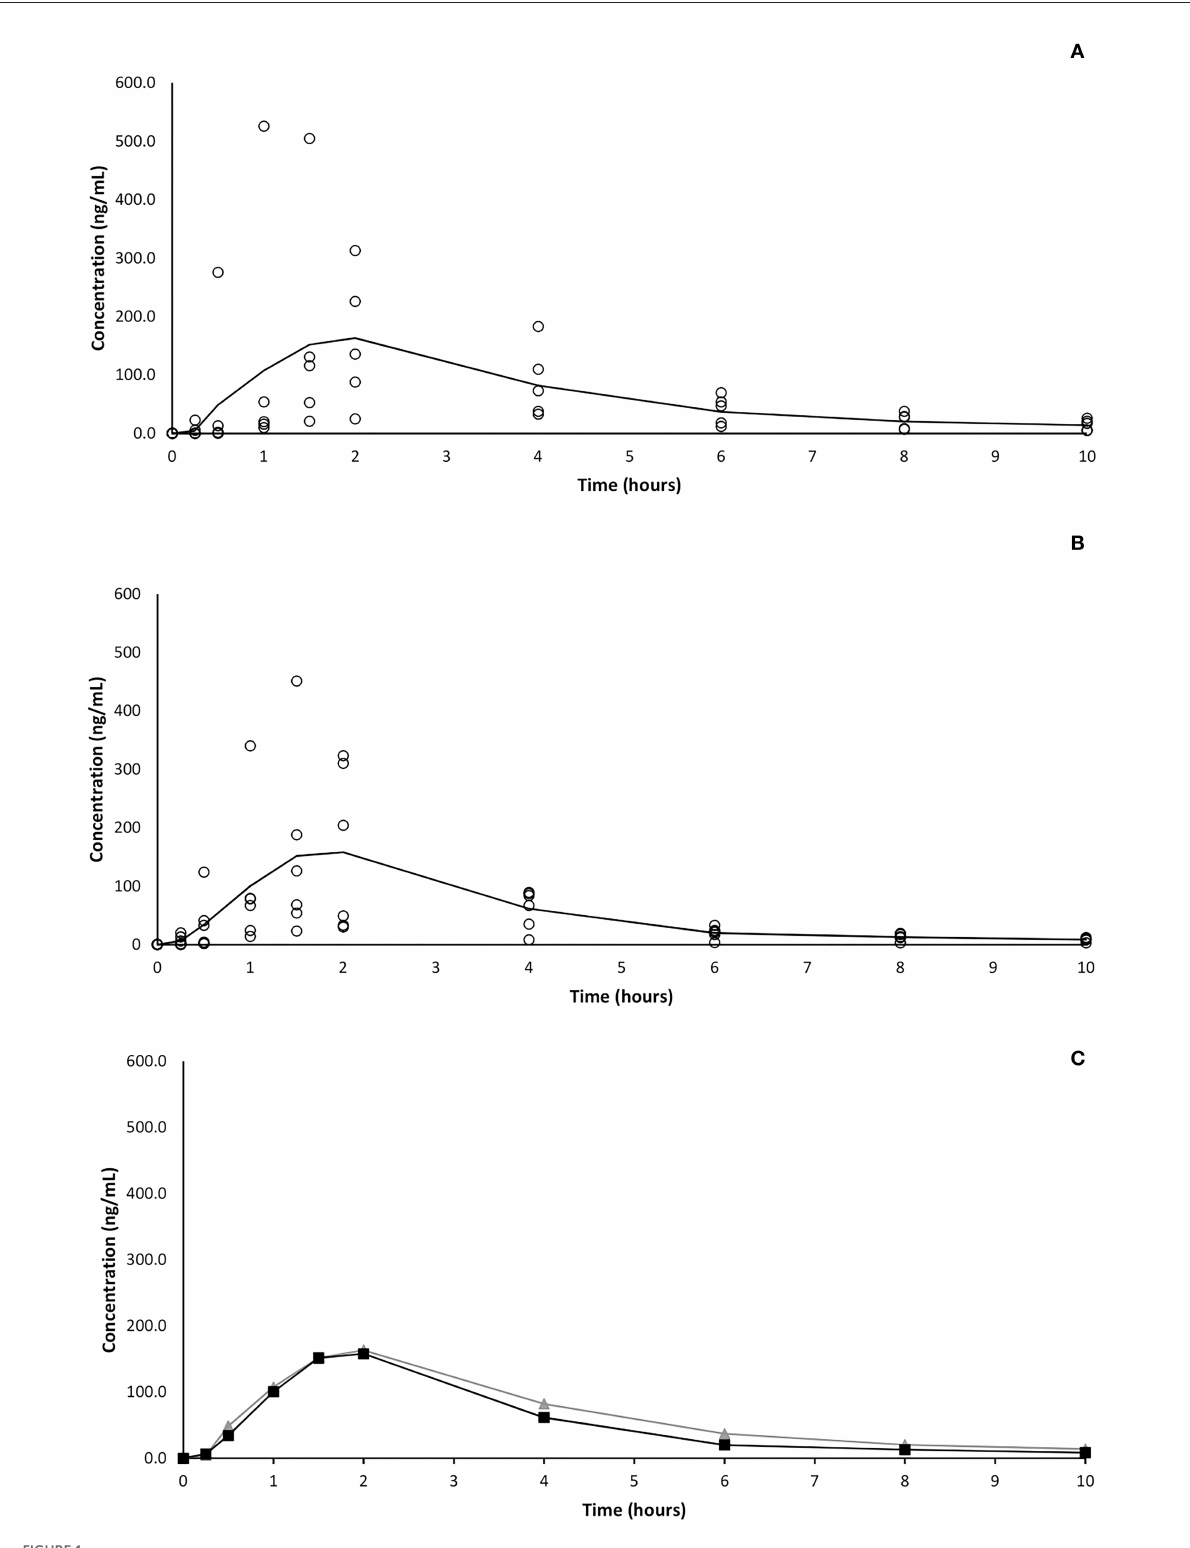
FIGURE1 Average (solid line) and single (circles) CBD plasma concentrations vs. time following single oral (A) and OTM (B) treatment and comparison (C) of mean concentrations of the two different route of administration (oral in gray and OTM in